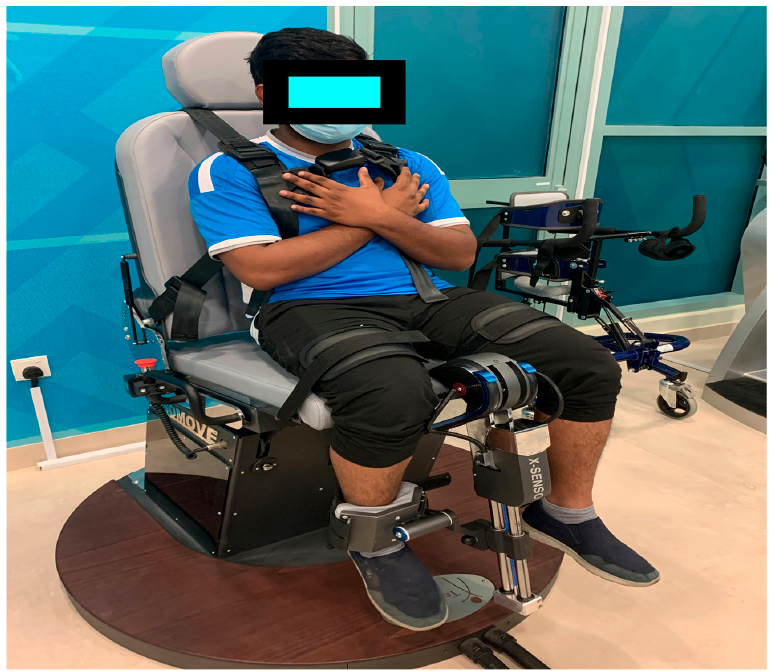
Figure 2. Measurement of the maximal voluntary isometric contraction at 90° using an ISO-MOVE isokinetic dynamometer. isokinetic